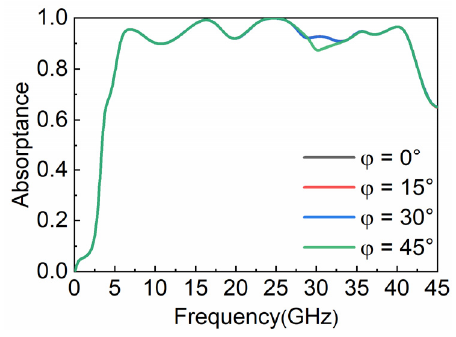
Figure 3. Absorptance at different polarization angles.